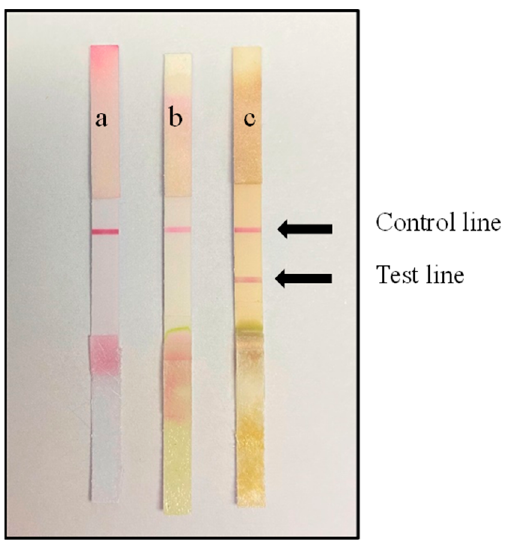
Figure 2. The successful detection of CGMMV using the developed test strip. ( a ) The bu ff er (0.05 M PBS) chromatography result is negative. ( b ) The test result of healthy cucumber leaves is